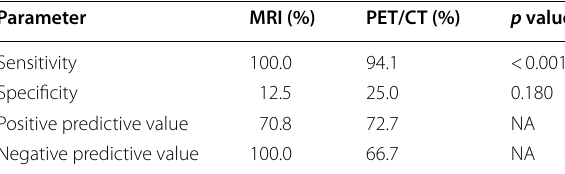
Table 4 Diagnostic performance of MRI versus PET/CT